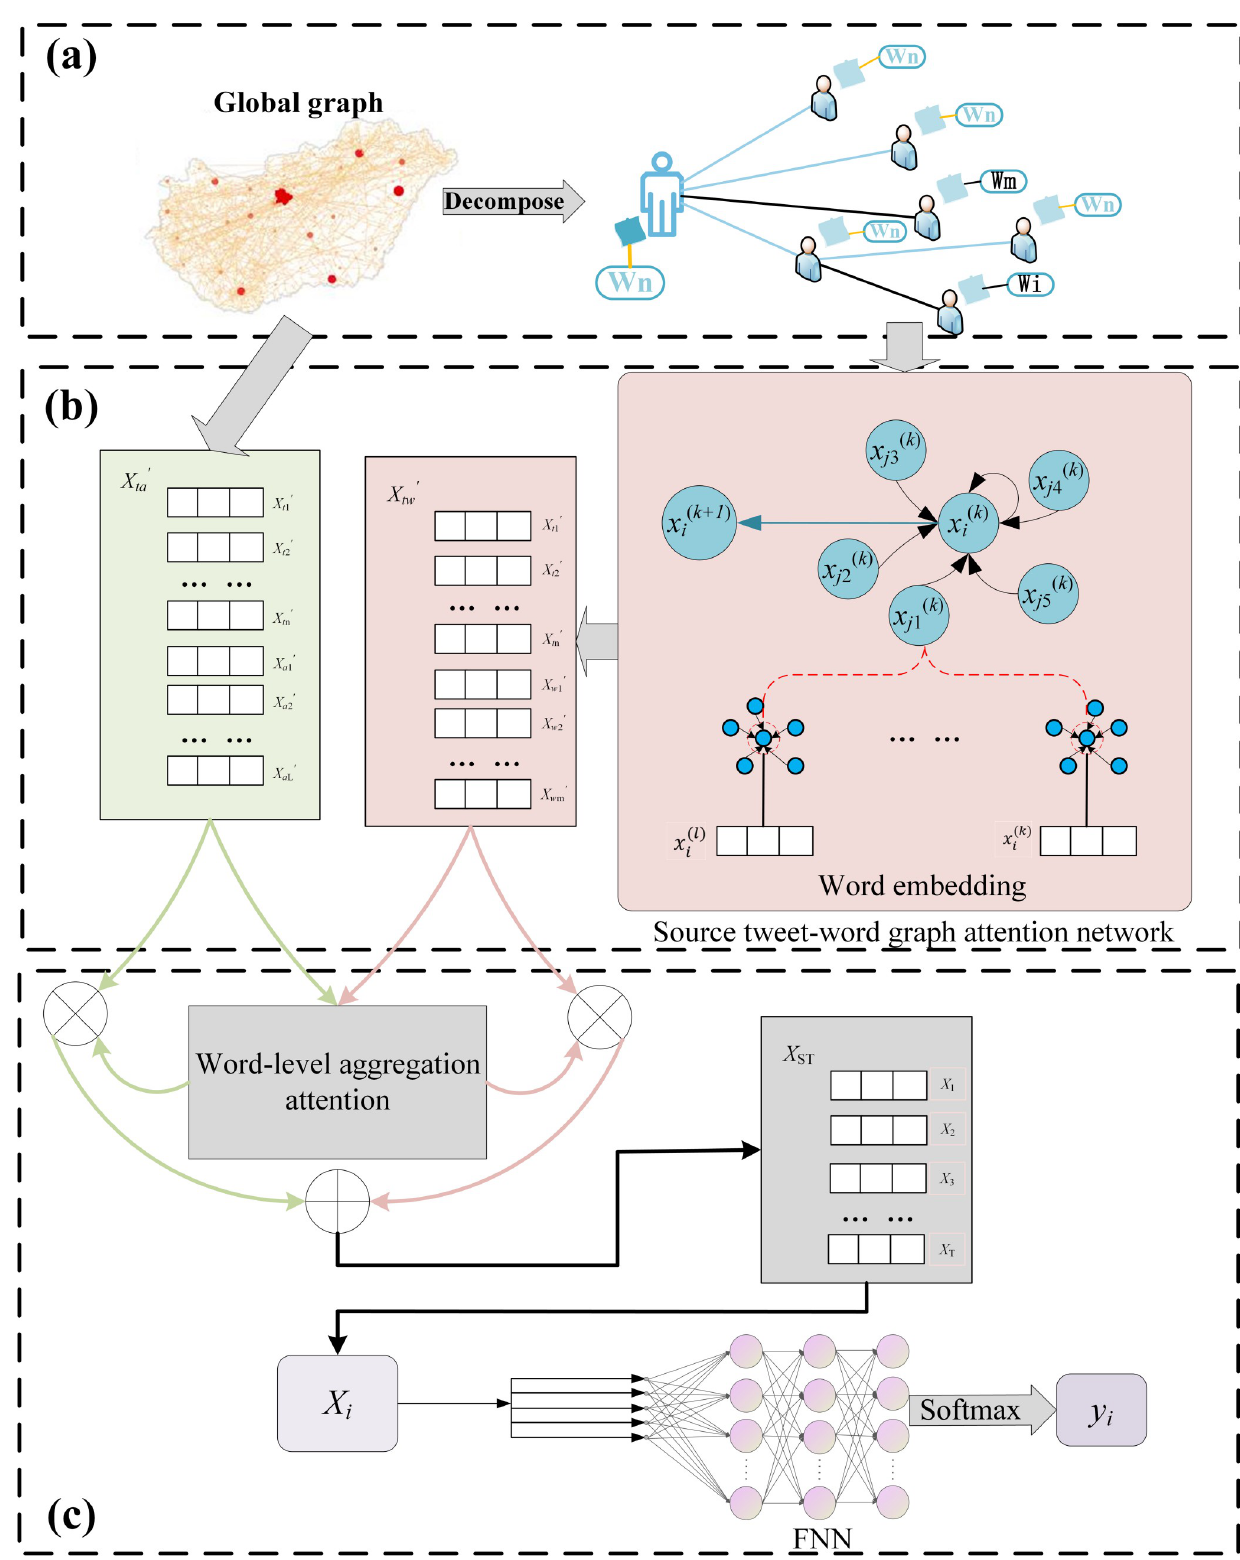
Fig 3. Overview of STWA: (a) input of STWA; (b) processing layer; (c) text semantic association learning and rumor detection layer.